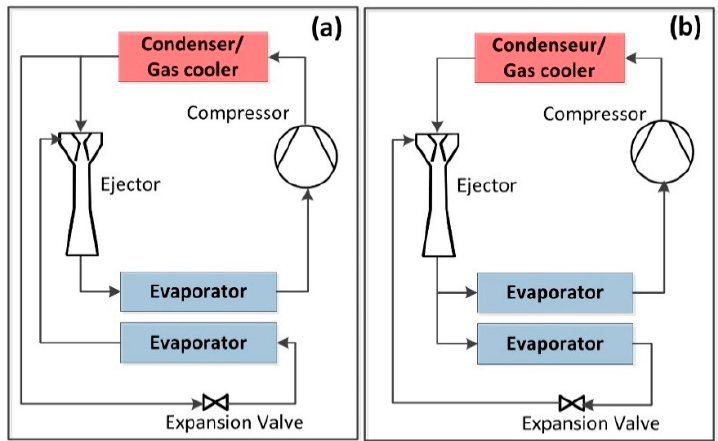
Figure 9. Variants of the conventional EERC: ( a ) Condenser outlet split cycle (COS) [84]; ( b ) diffuser outlet split cycle (DOS) [85].